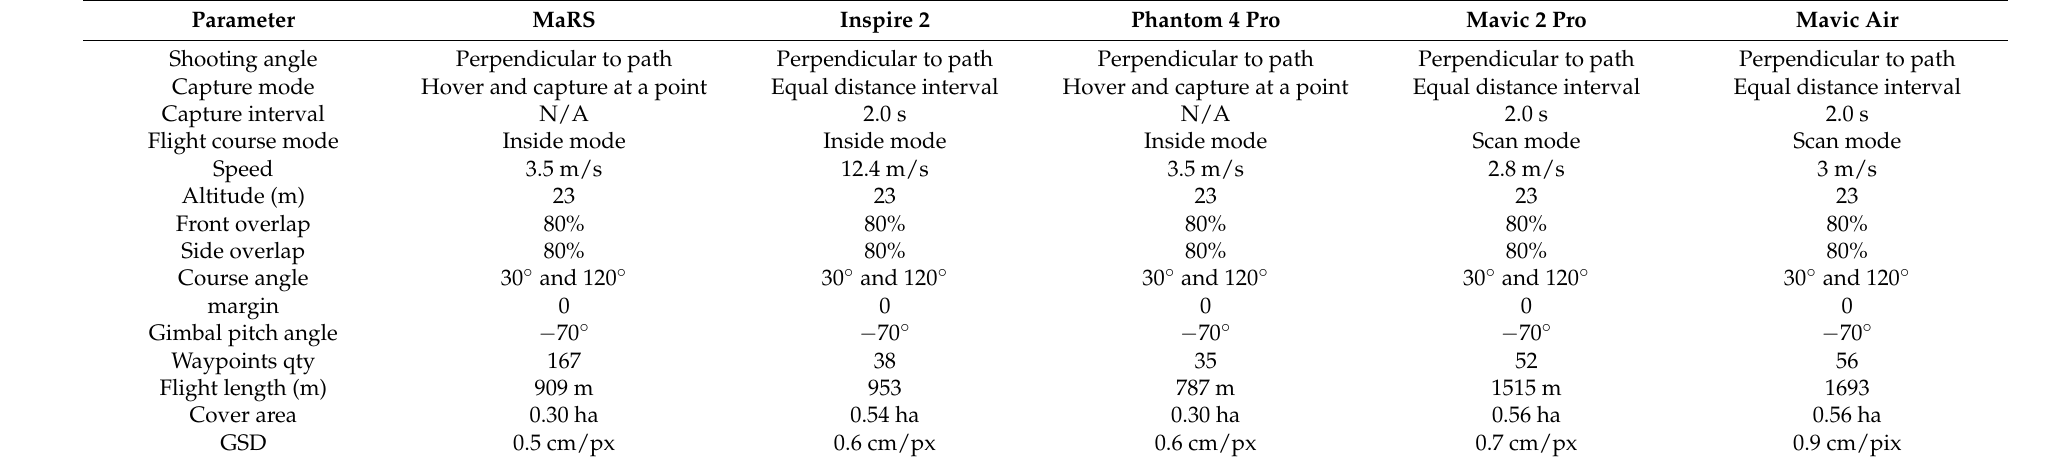
Table 3. Parameters for each flight using DJI GS Pro 3-Map area